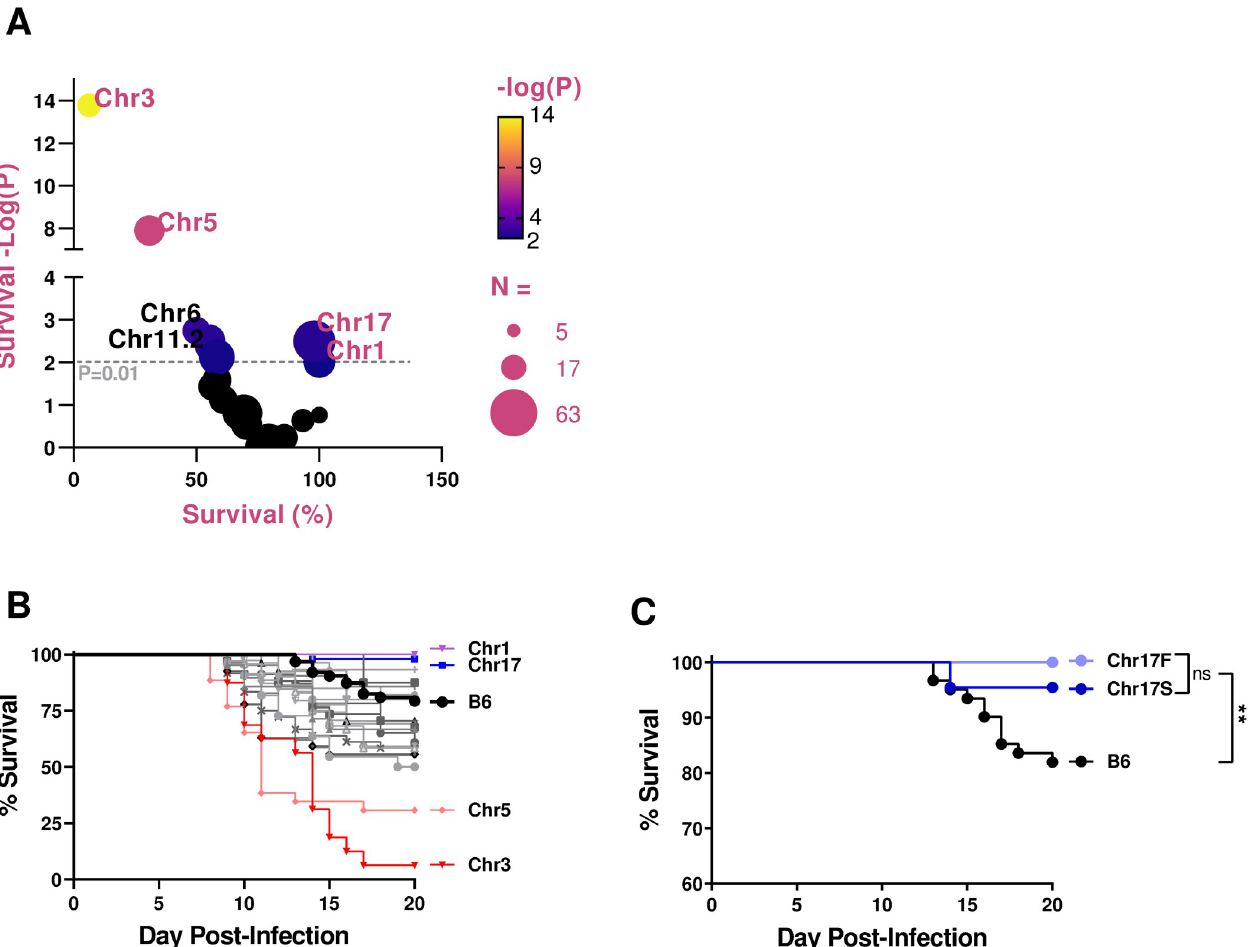
Fig 3. IAV challenge of B6.Chr PWD consomic mice reveals a wide range of susceptibility phenotypes. B6 control and B6.Chr PWD male and female mice were infected with sex-adjusted doses of PR8 as in Fig 2B . Significance of difference in survival between B6 and each consomic strain (male and female data pooled by strain) was assessed by Mantel-Cox test. ( A ) A bubble volcano plot showing significance of survival (-Log 10 (P)) compared with B6 plotted vs. % survival, across all consomic strains, with strains of interest labeled. The size of the circle indicates the total number of animals studied per strain (N), as indicated. ( B ) Survival analysis of B6 and consomic mice, with strains of interest labeled (male and female data pooled by strain). Complete data on survival analysis for each strain are presented in Table 1 . ( C ) Comparison of survival between B6 and B6.Chr17 PWD consomics, Chr17S (short) and Chr17F (full), (male and female data pooled by strain). �� signifies a P value of < 0.01, as determined by Mantel-Cox